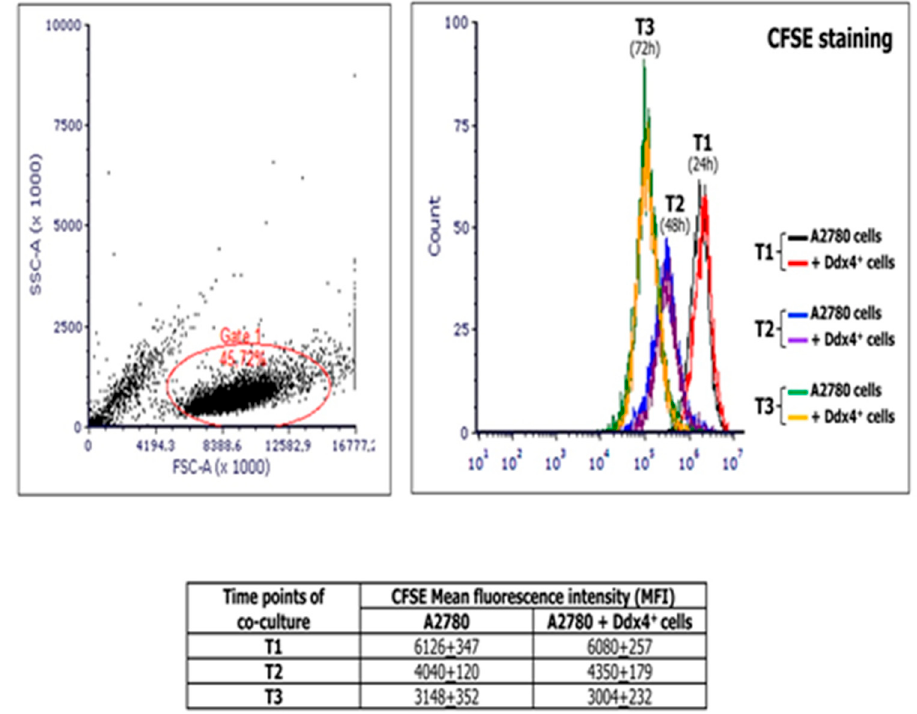
Figure 3. Measurement of the A2780 proliferation extent at di ff erent time points of co-culture with Ddx4 + cells derived from a representative A2 patient. The image shows carboxyfluoresceinsuccinimidyl ester (CFSE) assay results, in terms of mean fluorescence intensity (MFI), derived from co-culture experiments performed in triplicate by using ML-Ddx4 + cells isolated from a representative A2-OC patient (pt #12). As depicted, after cell cycle synchronization, A2780 cells exhibited an homogeneous doubling time of 24 h and hystograms of co-cultured cells and controls were perfectly overlapping at each time point (numbers in the table correspond to MFI